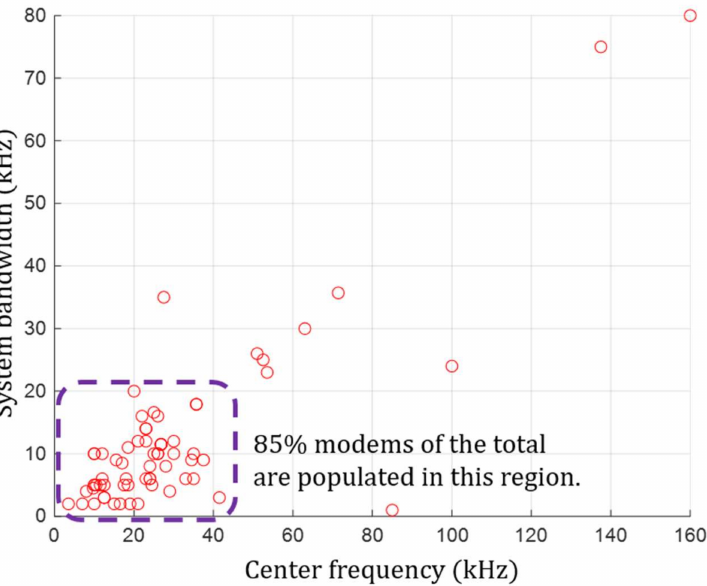
Figure 1. The scatter plot illustrating the pairs of center frequency and system bandwidth of under- water acoustic communication modems specified in [25].